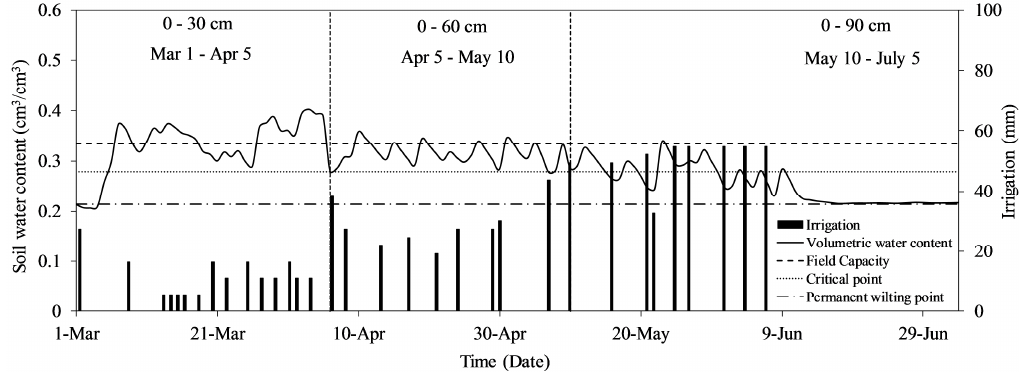
Figure 3. Soil water content of controlled lysimeters (T control ), and the amount of applied irrigation at each T control during the soybean growing season.